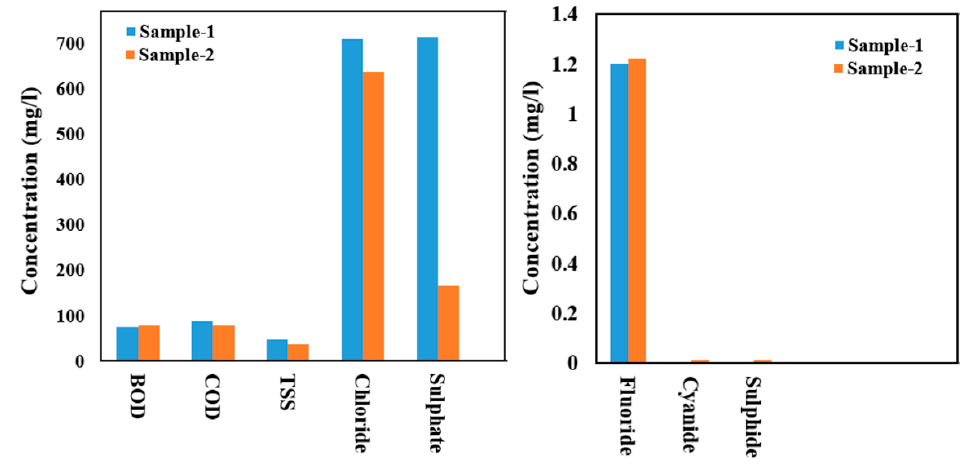
Figure 2. Concentration (mg/L of BOD, COD, TSS, chlorides, sulfate, fluoride, cyanide and sulfide ions in wastewater samples-1 and -2.